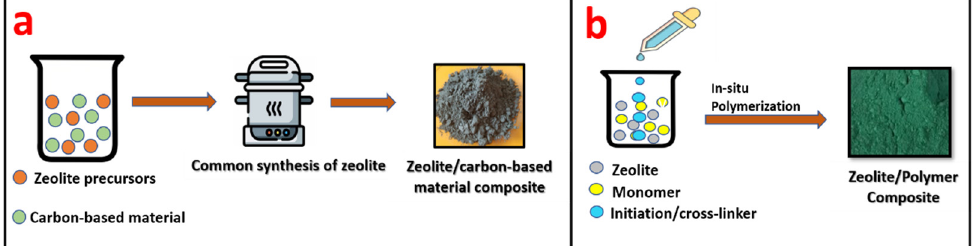
Figure 13. Schematic representation of ( a ) the synthesis of a zeolite/carbon-based material composite and ( b ) a zeolite/polymer composite.